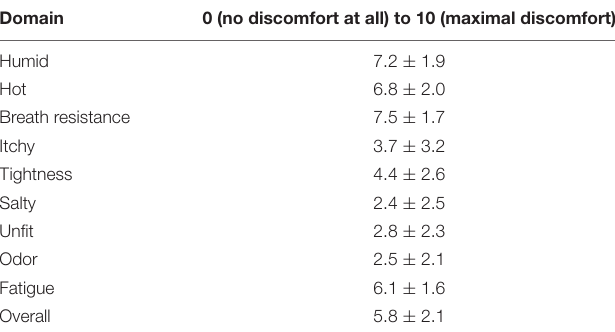
TABLE 3 | Perceived discomfort level when wearing the face mask during the